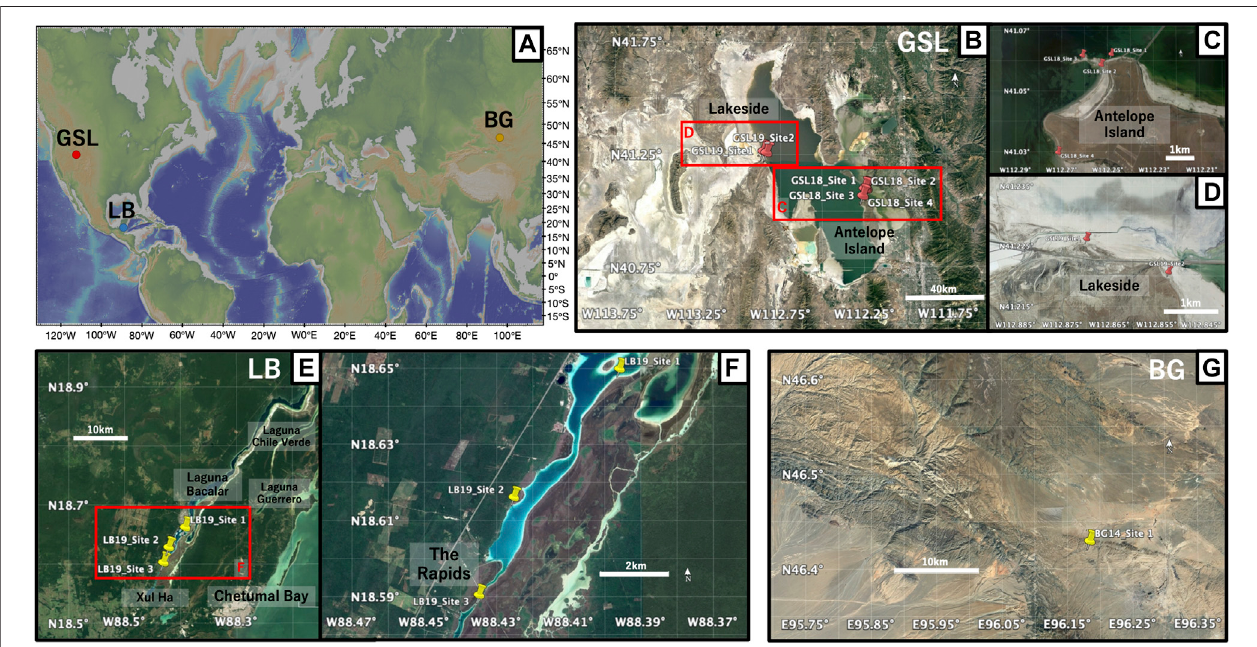
FIGURE 1 | (A) Global map of the locations of three microbialite samples: Great Salt Lake (GSL), Utah; Laguna Bacalar (LB), Quintana Roo, MX; Bayan Gol formation(BG),SouthwesternMongolia.The fi gurewasmadewithGeoMapApp (www.geomapapp.org)(Ryanetal.,2009). (B) Satelliteimageofthesamplinglocations ofmicrobialitesat GSL (C) Close-upofGSL18studylocalitiesattheAntelope Islandand (D) GSL19samplingsitesat Lakeside. (E) Satelliteimageofsamplinglocations of microbialites at LB. (F) Close-up of LB19 study localities and three sampling sites. (G) Satellite image of sampling locations at BG. Imagery from July 2019 for GSL, april 2018 for LB, and april 2019 for BG, © 2019 Google, Image Landsat/Copernicus.